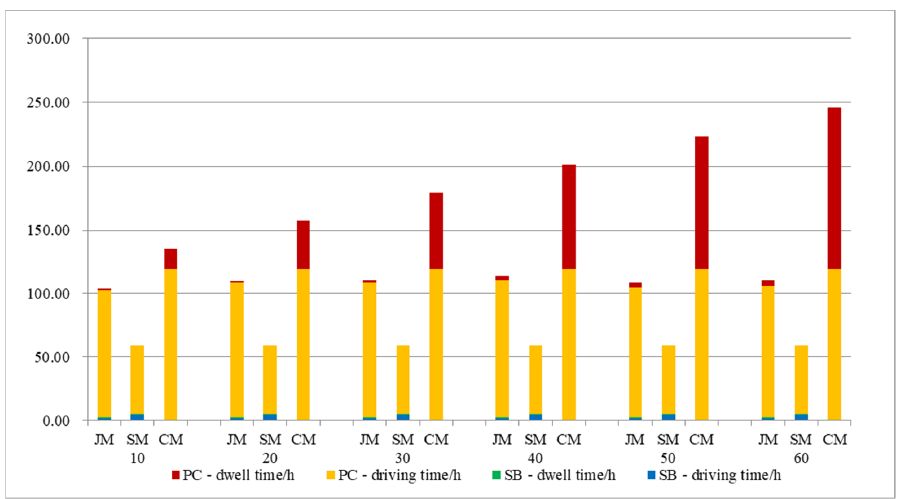
Figure 19. Various cost variations with parameter t u